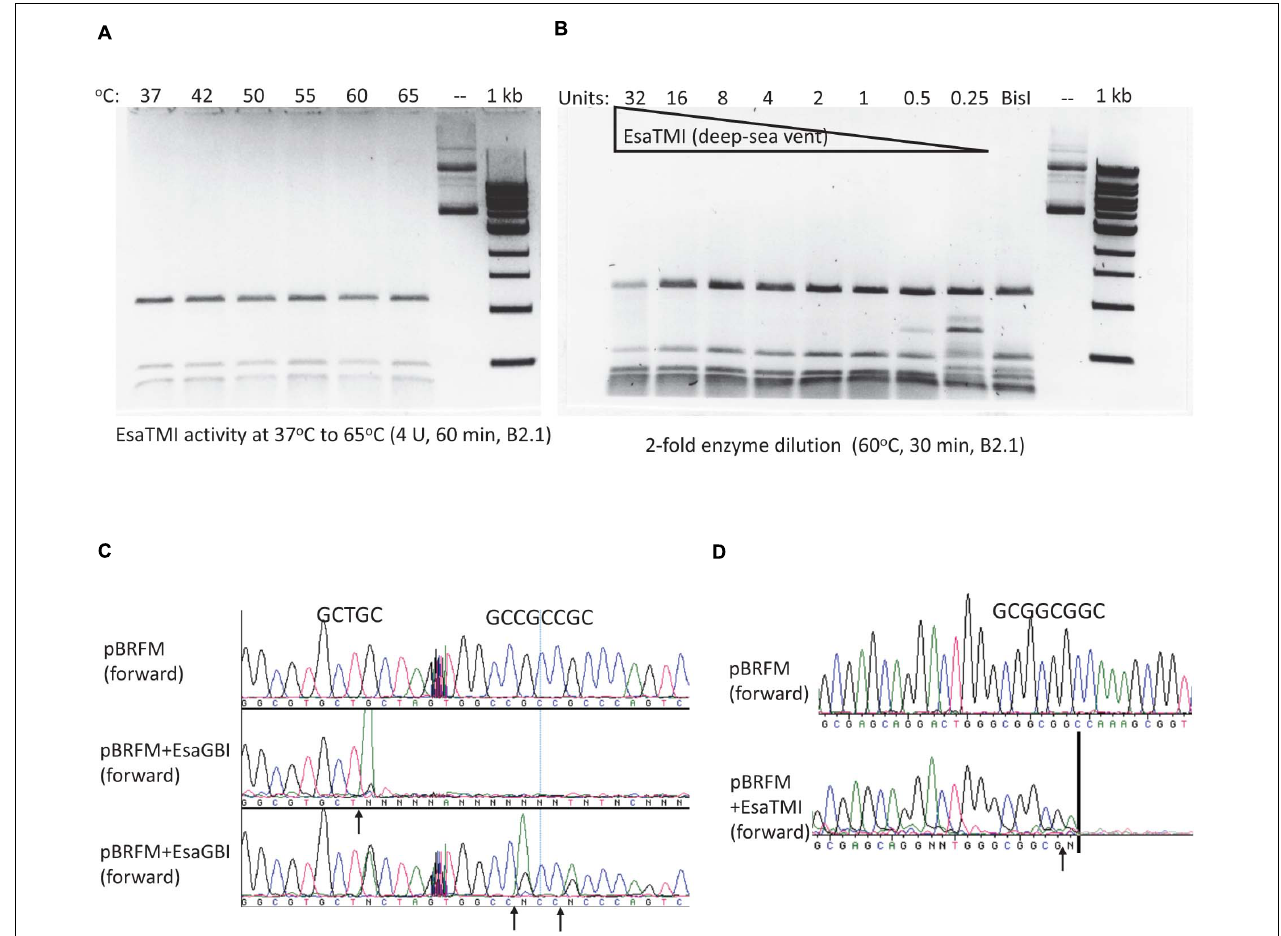
FIGURE 7 | EsaTMI (BisI homolog derived from a deep-sea vent metagenome) restriction activity at various temperatures and EsaTMI enzyme titration. (A) Digestion of modified plasmid pBRFM (pBR322- fnu4HIM ) by EsaTMI (4 U) at 37 to 65 ◦ C in B2.1 for 1 h. (B) Two-fold serial dilution of EsaTMI in restriction of pBRFM DNA (Gm5CNGC) at 60 ◦ C. Over-digestion at 32 U showed some smearing due to star activity. (C,D) Cleavage site mapping by DNA sequencing after digestion by EsaGBI and EsaTMI, respectively. The vertical bar in (D) indicates that the sequencing peaks are flat after this